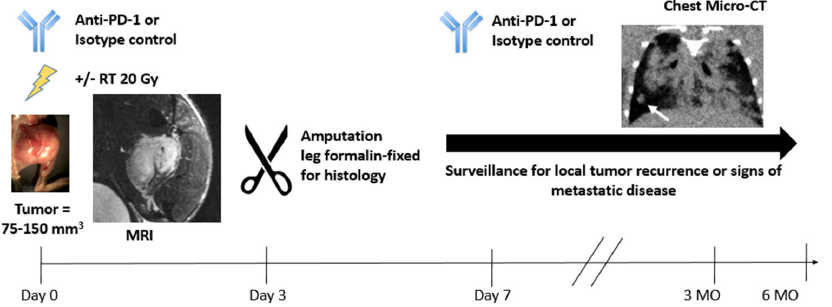
Figure 2. Examples of MRI and micro-CT images in the p53/MCA model and the schematics of the preclinical arm of the clinical trial.